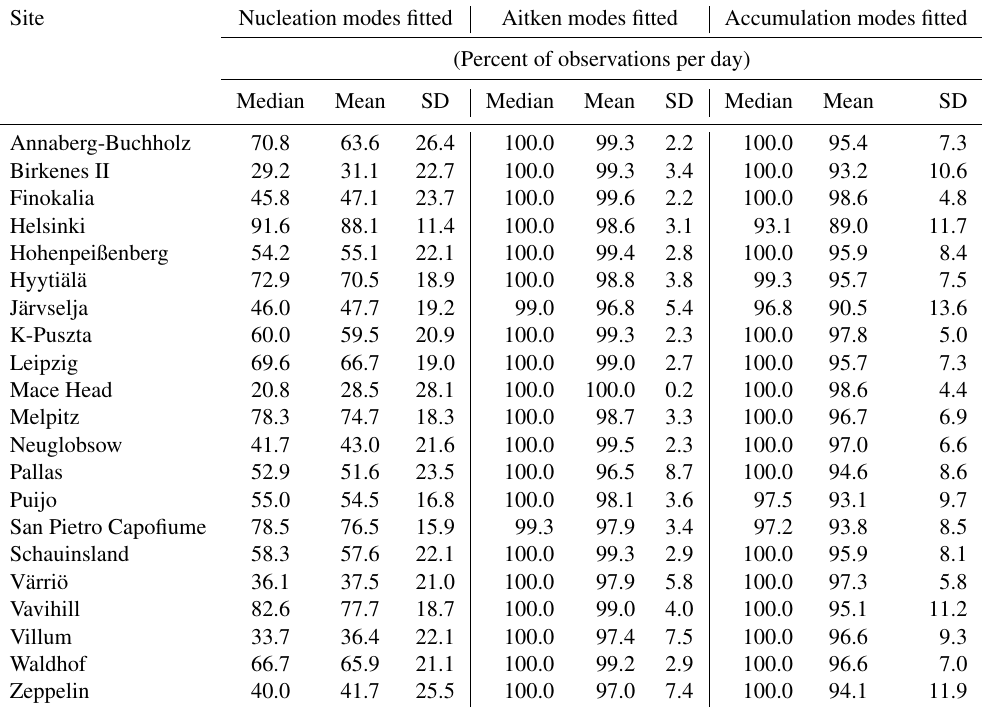
Table 2. Daily median and mean coverage and the standard deviation of the coverage of the fitted nucleation, Aitken, and accumulation modes at measurement sites during the whole measurement time